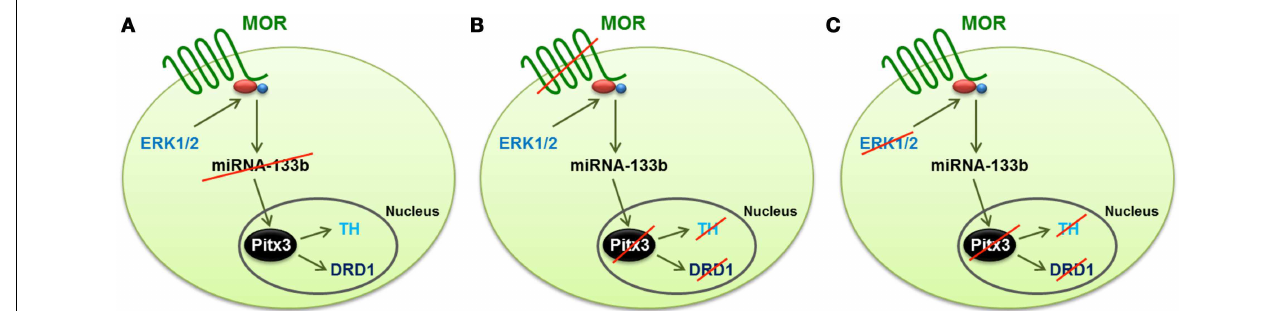
Silencing MOR by specific morpholinos produces an increase in the expression of miRNA-133b, and reduces the transcription level of Pitx3, TH, and DAT. (C) Inhibition of ERK1/2, even when the MOR receptor is activated by morphine, produces the same effect as knockdown of the receptor, i.e., the expression of miR-133b increases, and hence, the expression of Pitx3,TH, and DAT decreases, which reduces the level of dopaminergic neuron